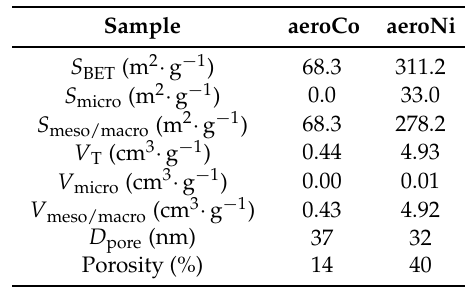
Table 2. Porosity data for aeroCo and aeroNi *.